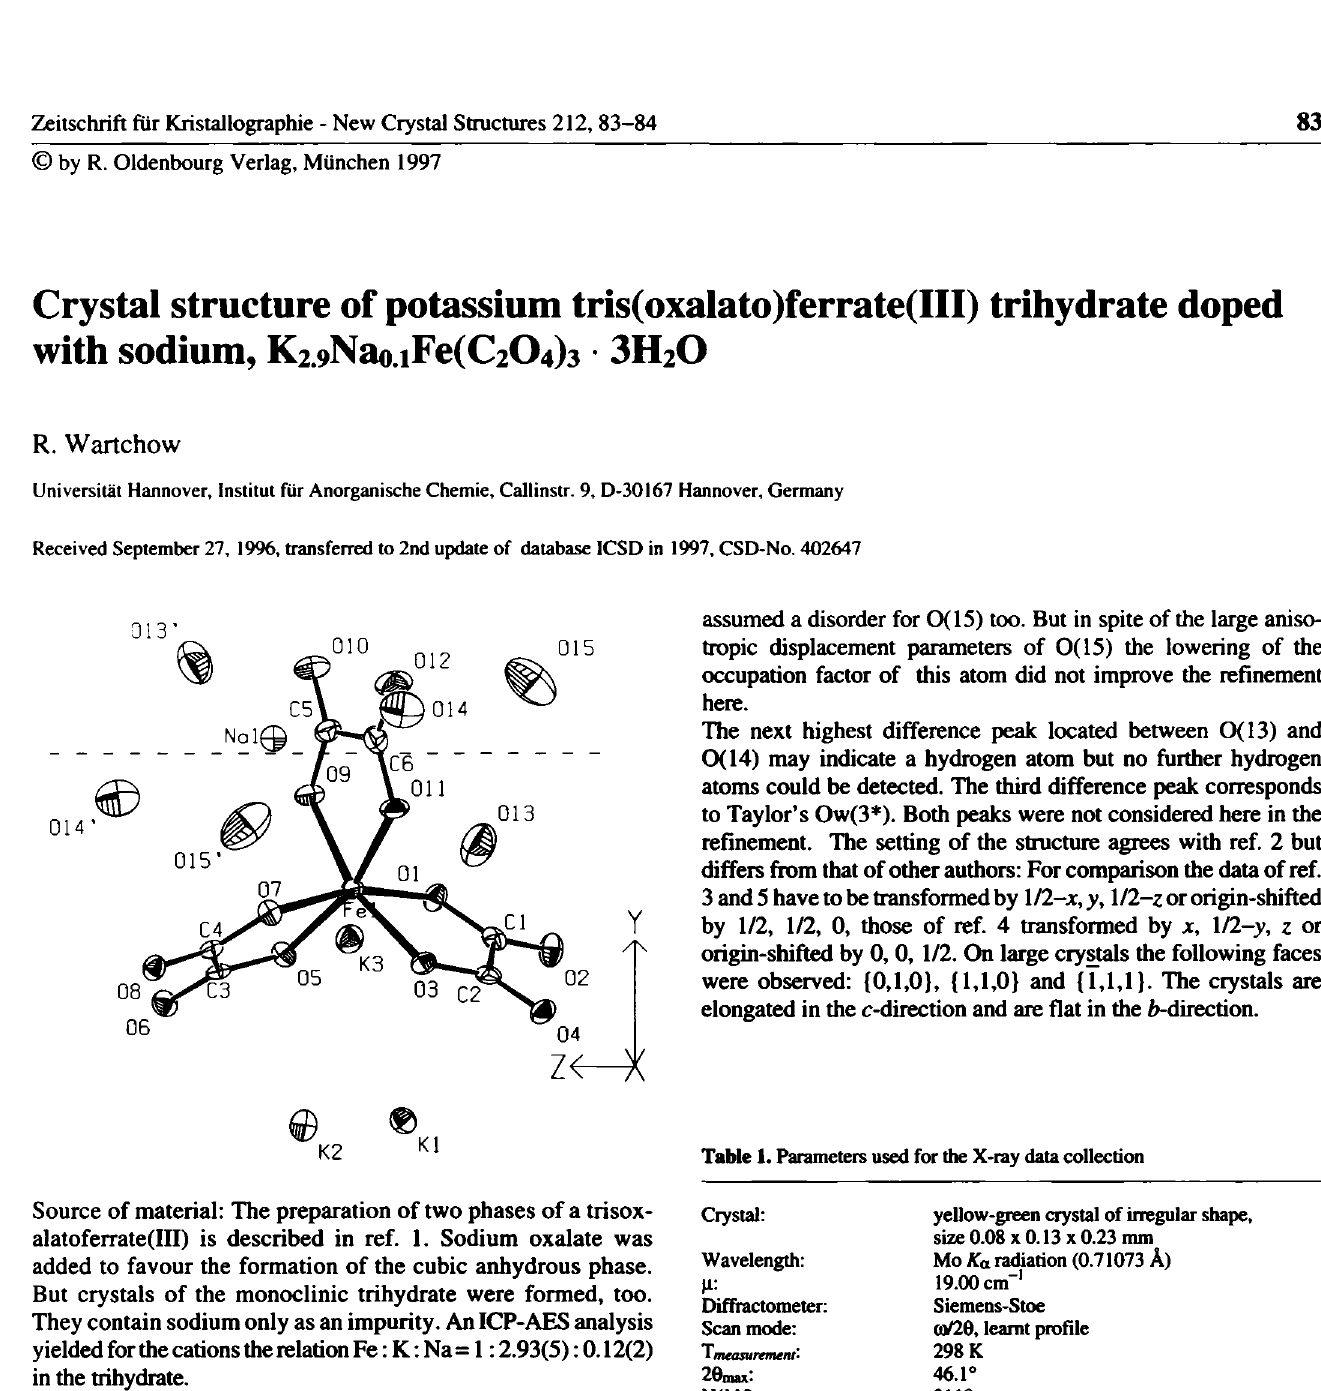
Table 2. Final atomic coordinates and displacement parameters (in Â 2